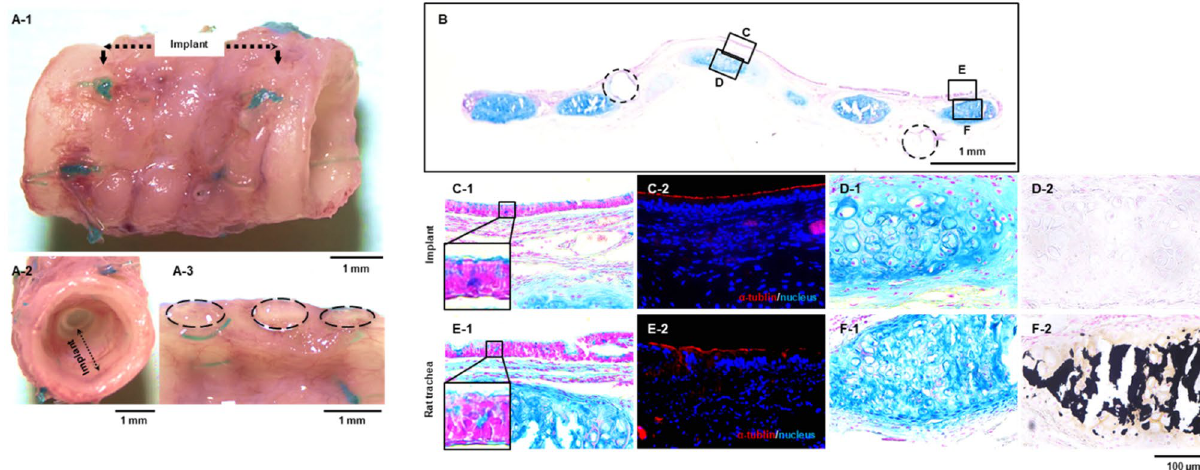
Figure 4. Histological analysis of tracheal analogue implant in the chronic phase. Macroscopic view of tracheal analogue 8 months after implantation at the outer surface ( A-1 ), lumen ( A-2 ) and longitudinal cross-section ( A-3 ). Longitudinal cross-section of the tracheal analogue implanted at rat trachea for 8 months and stained in alcian blue ( B ). Magnified sections of the lumen ( C ) and cartilage ( D ) of the tracheal analogue, and native rat tracheal lumen ( E ) and cartilage ( F ) ( C-1 , D-1 , E-1 and F-1 , alcian blue stain for the mucus and cartilage matirix; ( C-2 ) and ( E-2 ), α-tubulin for the ciliated epithelium and DAPI for the nucleus, ( D-2 ) and ( F-2 ); vonkossa stain for calcium deposition). The dashed circles in B indicate the anastomosis